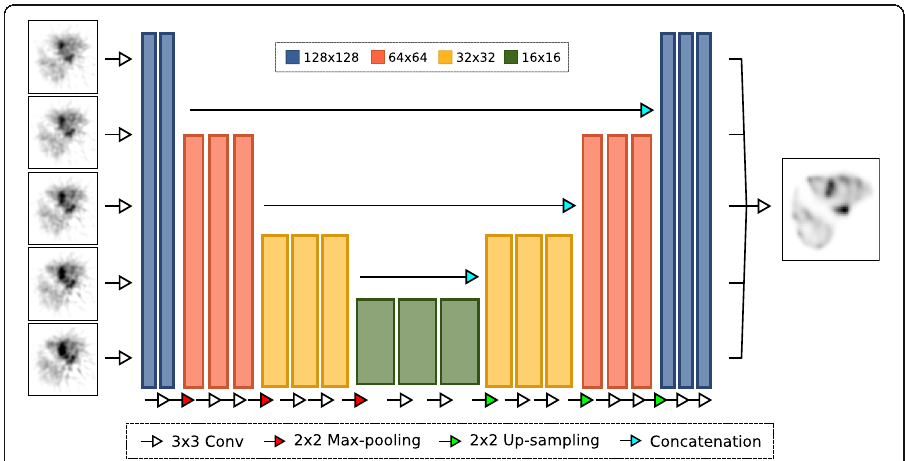
Fig. 1 Schematic of the encoder-decoder convolutional neural network with five input slices as used in this study. Left are examples of the FBP input reconstructions and right the associated ground truth